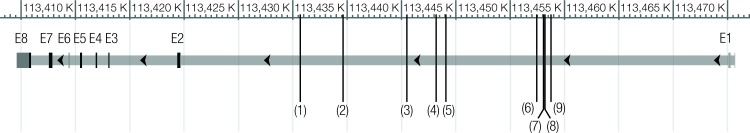
Location of candidate SNPs under balancing selection in DRD2.E1-8 are exons 1 to 8. (1) rs60599314, (2) rs79549222, (3) rs12574471, (4) rs80215768, (5) rs76581995, (6) rs80014933, (7) rs74751335, (8) rs77264605, (9) rs76499333.